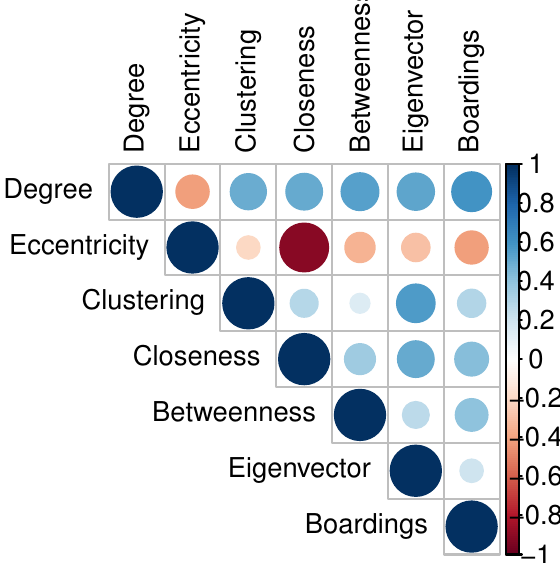
Figure 10. Pearson’s correlation coefficients of the centrality measures and boarding